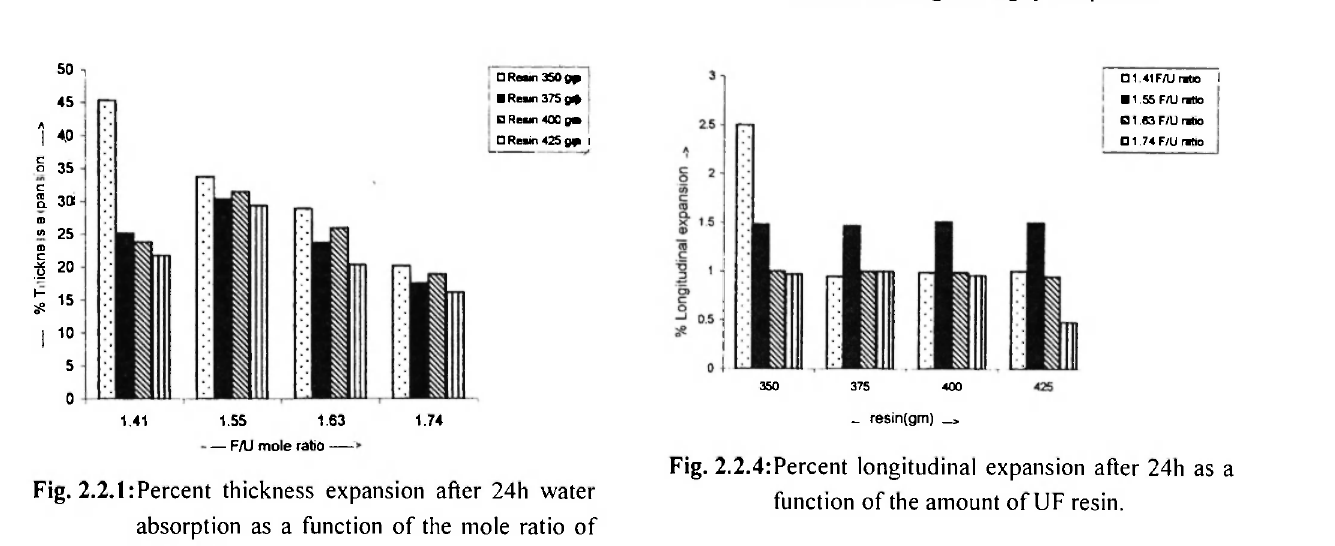
Fig. 2.2.1: Percent thickness expansion after 24h water absorption as a function of the mole ratio of HCHO:Urea.